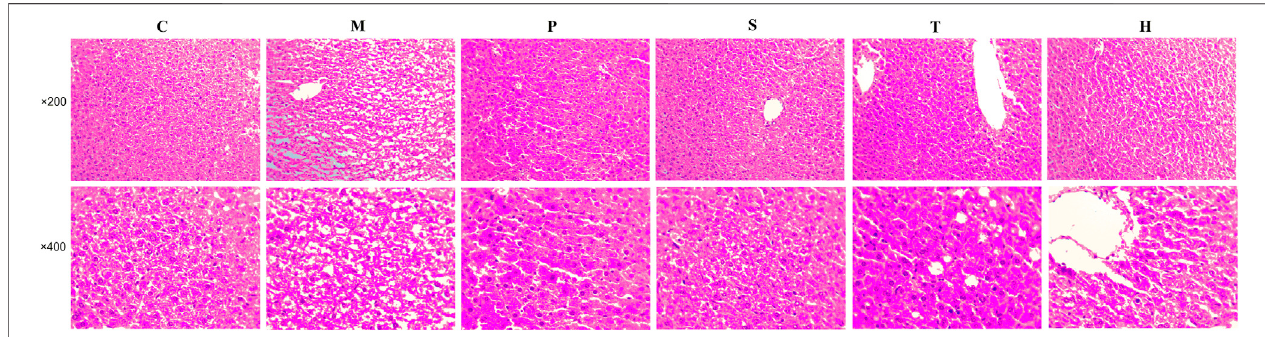
FIGURE1 | After treatment with salidroside, tyrosol, and hydroxytyrosol for12 weeks, liver tissues werestained with H&E staining (×200 and ×400). C: control; M: model; P: pioglitazone; S: salidroside; T: tyrosol; H: hydroxytyrosol.